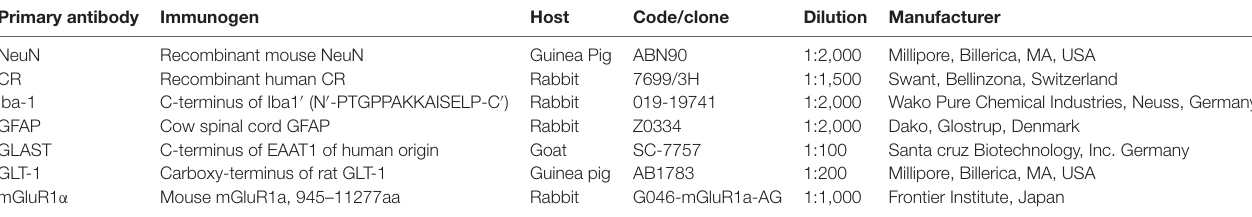
TABLE 1 | List of primary